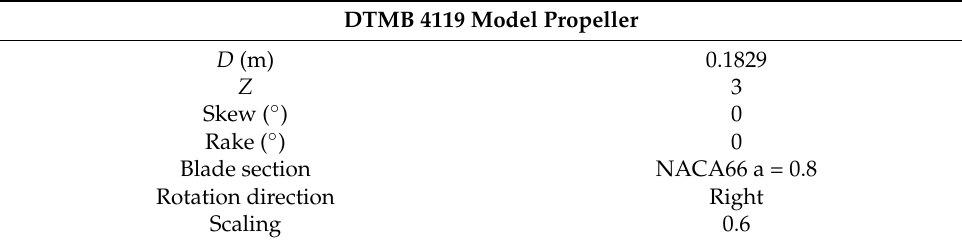
Table 2. Detailed parameters of the propeller DTMB4119.